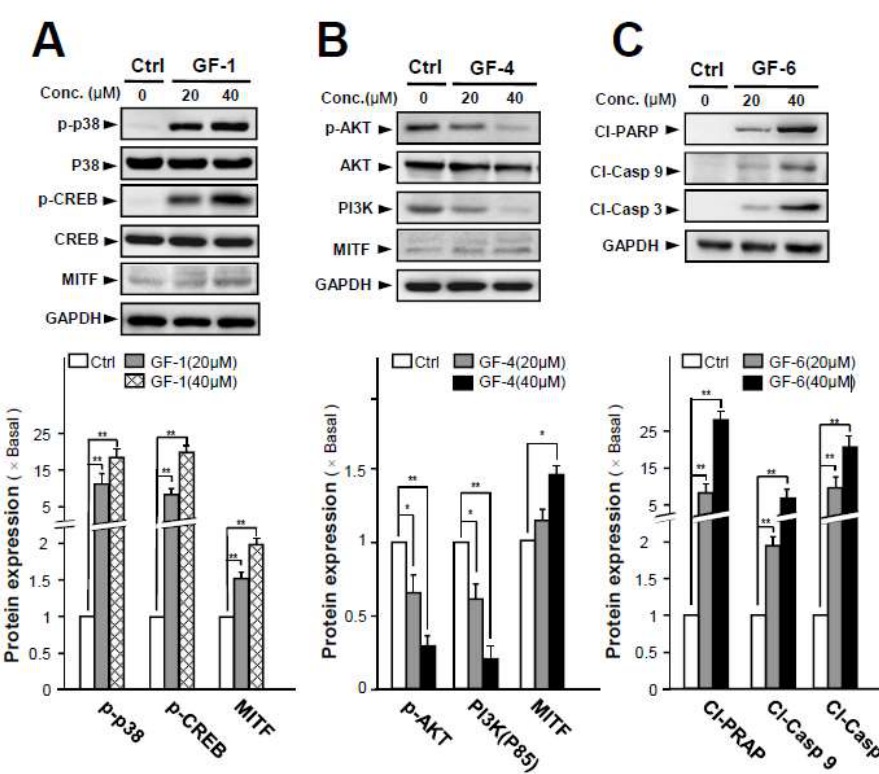
Figure 6. G. uralensis flavonoids induce differentiation or apoptosis via different signaling pathways in B16-F10 cells. B16-F10 cells were treated with various concentrations of selected flavonoids at concentration of 20 and 40 µ M for 48 h, after which protein expression in total cells were assayed by Western blot analysis. ( A ) GF-1 and GF-9 induced phosphorylations of p 38 (~38 kDa) and p-CREB (~43 kDa), as well as expression of and MITF (~60 kDa). ( B ) GF-4 induced protein expression of p-AKT (~60 kDa), PI3K(~85 kDa), and MITF (~60 kDa). ( C ) GF-6 induced expression of Cl-PARP(~89 kDa), Cl-Casp 9(~37 kDa), and Cl-Casp 3(~19 kDa). The relative abundance of each band to their own GAPDH was quantified, and the control levels were set at 1.0 (lower panel). Data are expressed as percentage of control, in means ± SEM ( n = 3).* p < 0.05, ** p < 0.01, compared with control.